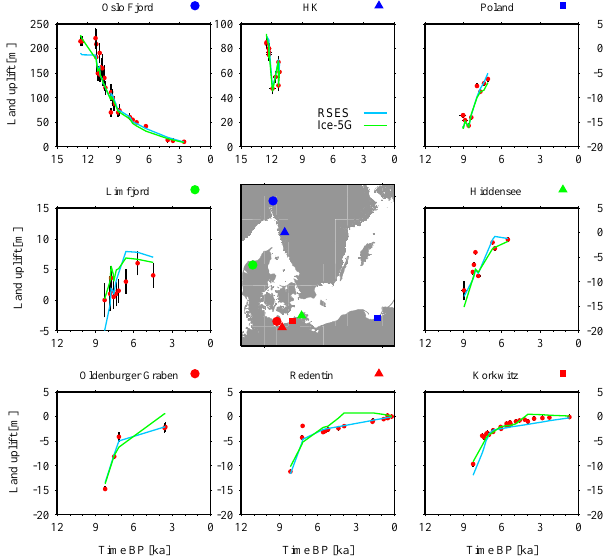
Figure 4. Comparison of RSL data (red dots) at selected locations Fig. 4. Comparison of RSL data (red dots) at selected locations to sea-level curves as calculated with the best earth model for a respective to sea-level curves as calculated with the best earth model for a region and ice model RSES(Lambeck et al., 1998, blue) and ICE-5G (Peltier,2004, green). respective region and ice model RSES (Lambeck et al., 1998, blue) and ICE-5G (Peltier, 2004,